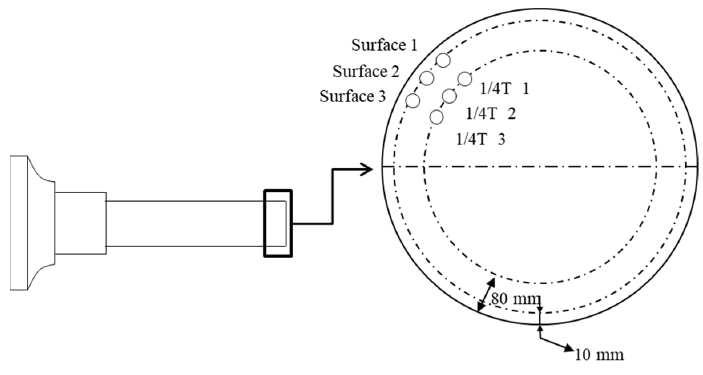
Figure 12. Test specimen extraction positions.